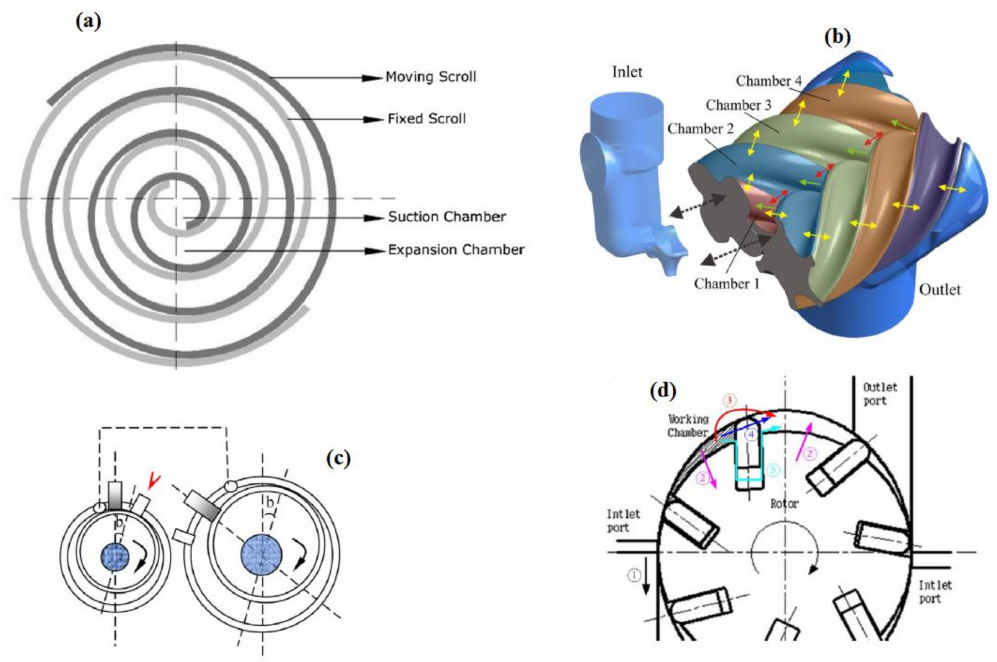
Figure 4. ( a ) Scroll expander [101]; ( b ) screw expander [102]; ( c ) piston expander [103]; and ( d ) rotary vane expander